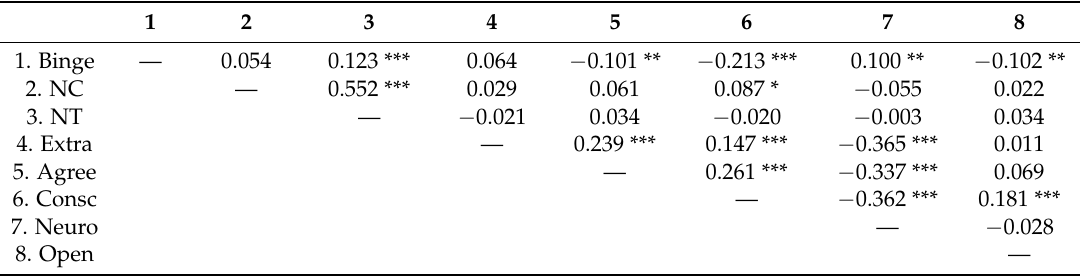
Table 1. Correlations between binge-watching, narrative transportation types, and